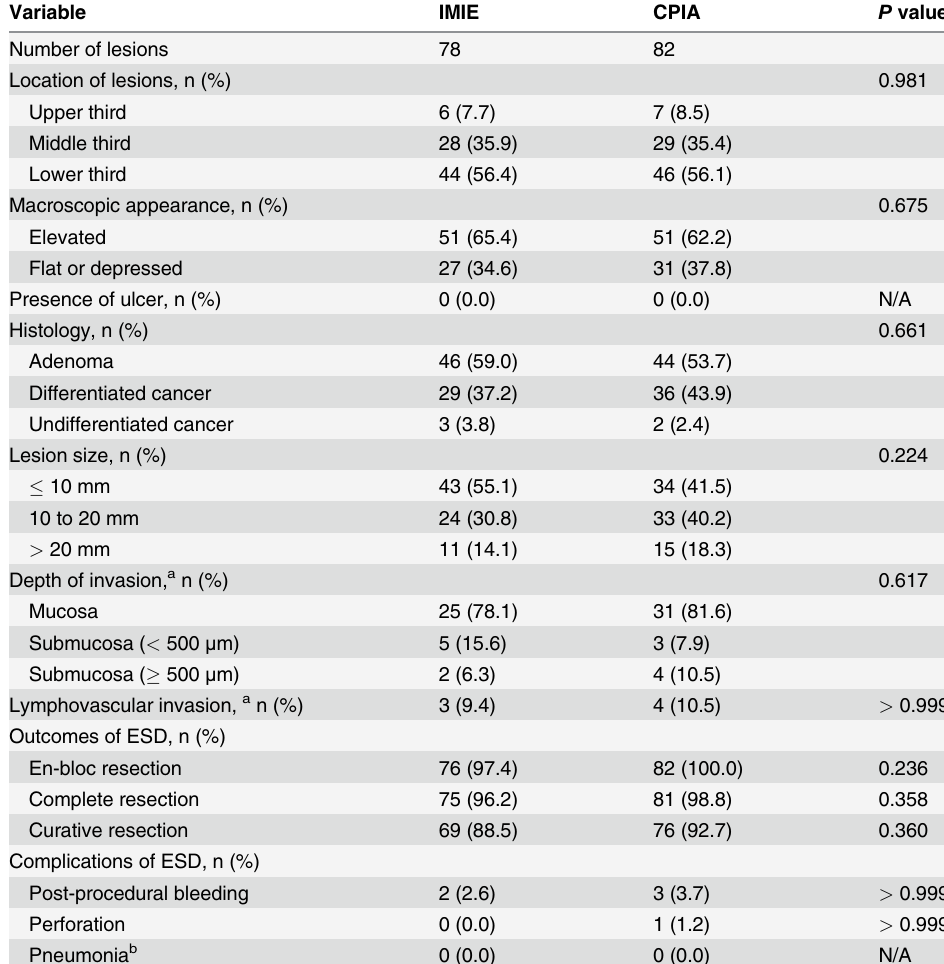
Table 3. Lesion characteristics and outcomes of endoscopic submucosal